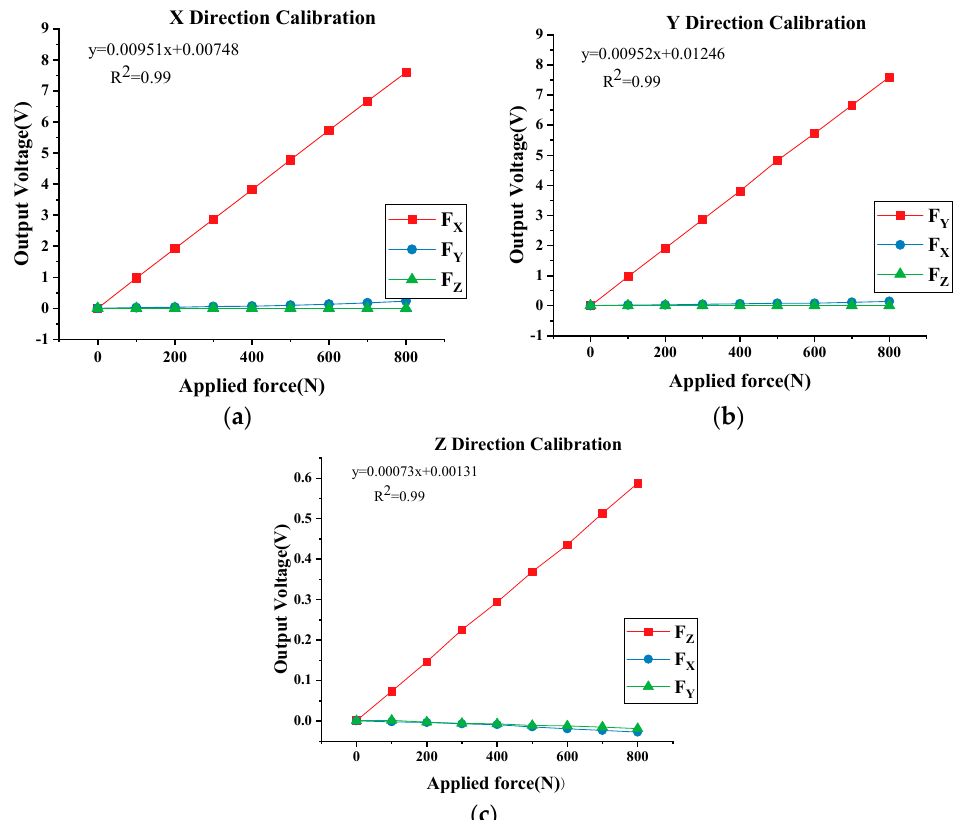
Figure 7. Calibration results: ( a ) X direction; ( b ) Y direction; ( c ) Z direction.